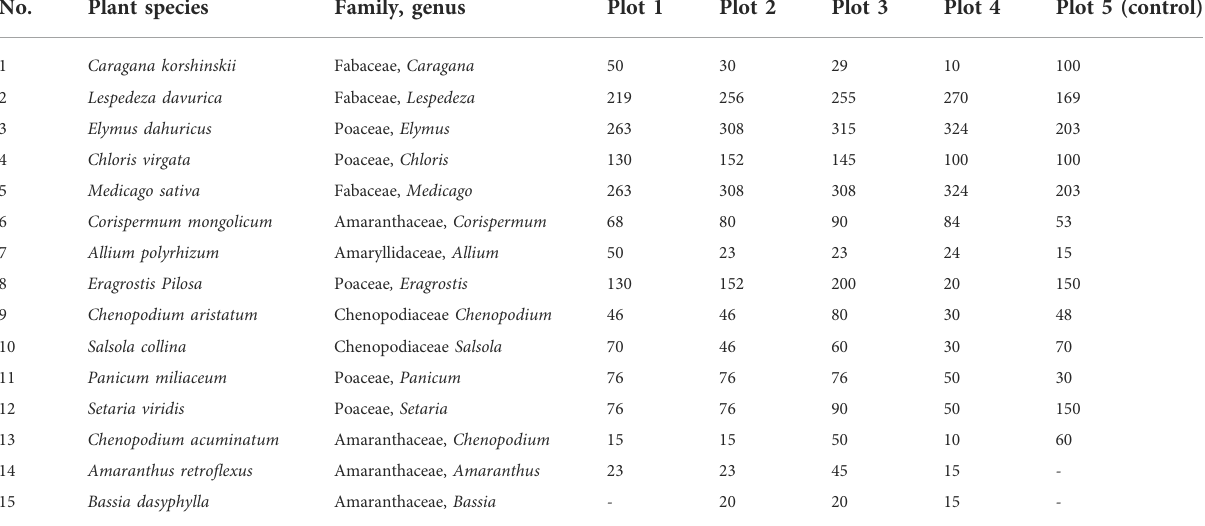
a Indicates that the plant did not appear in the surveyed quadrat.